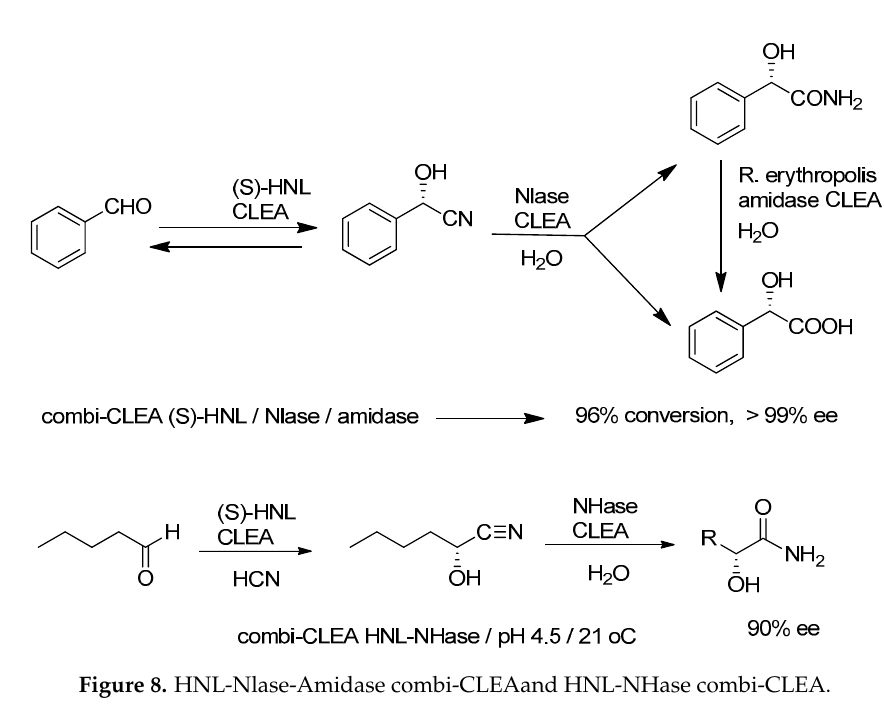
Figure 8. HNL-Nlase-Amidase combi-CLEAand HNL-NHase combi-CLEA.